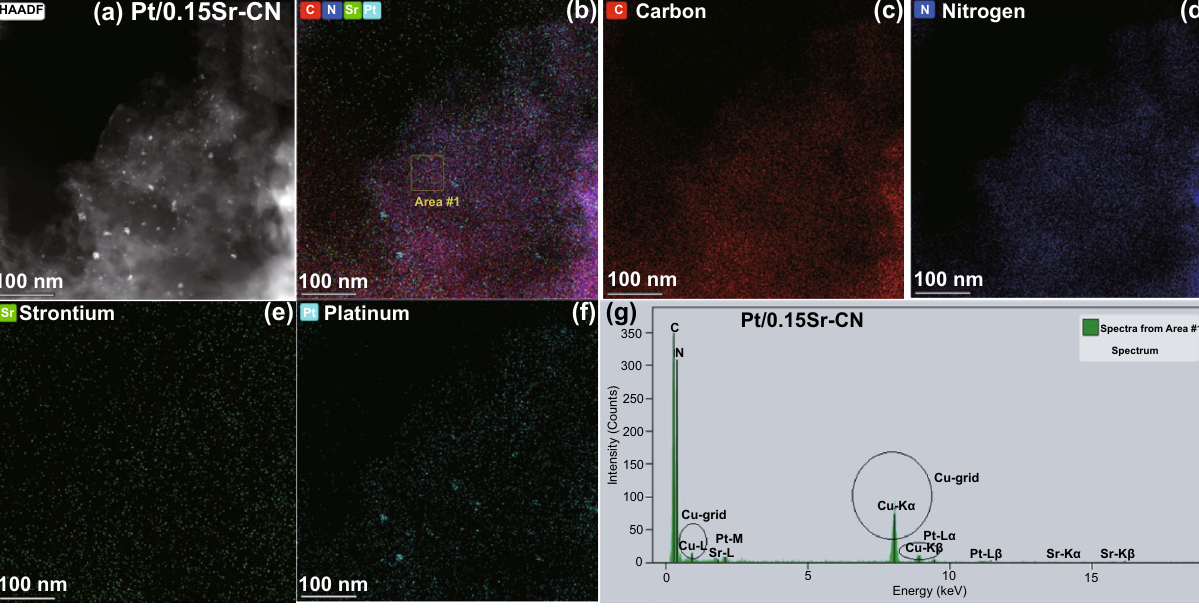
Fig. 4 TEM mappings of a, b Pt/0.15Sr-CN, c carbon element, d N element, e Strontium element, and f Platinum. g EDX spectrum of